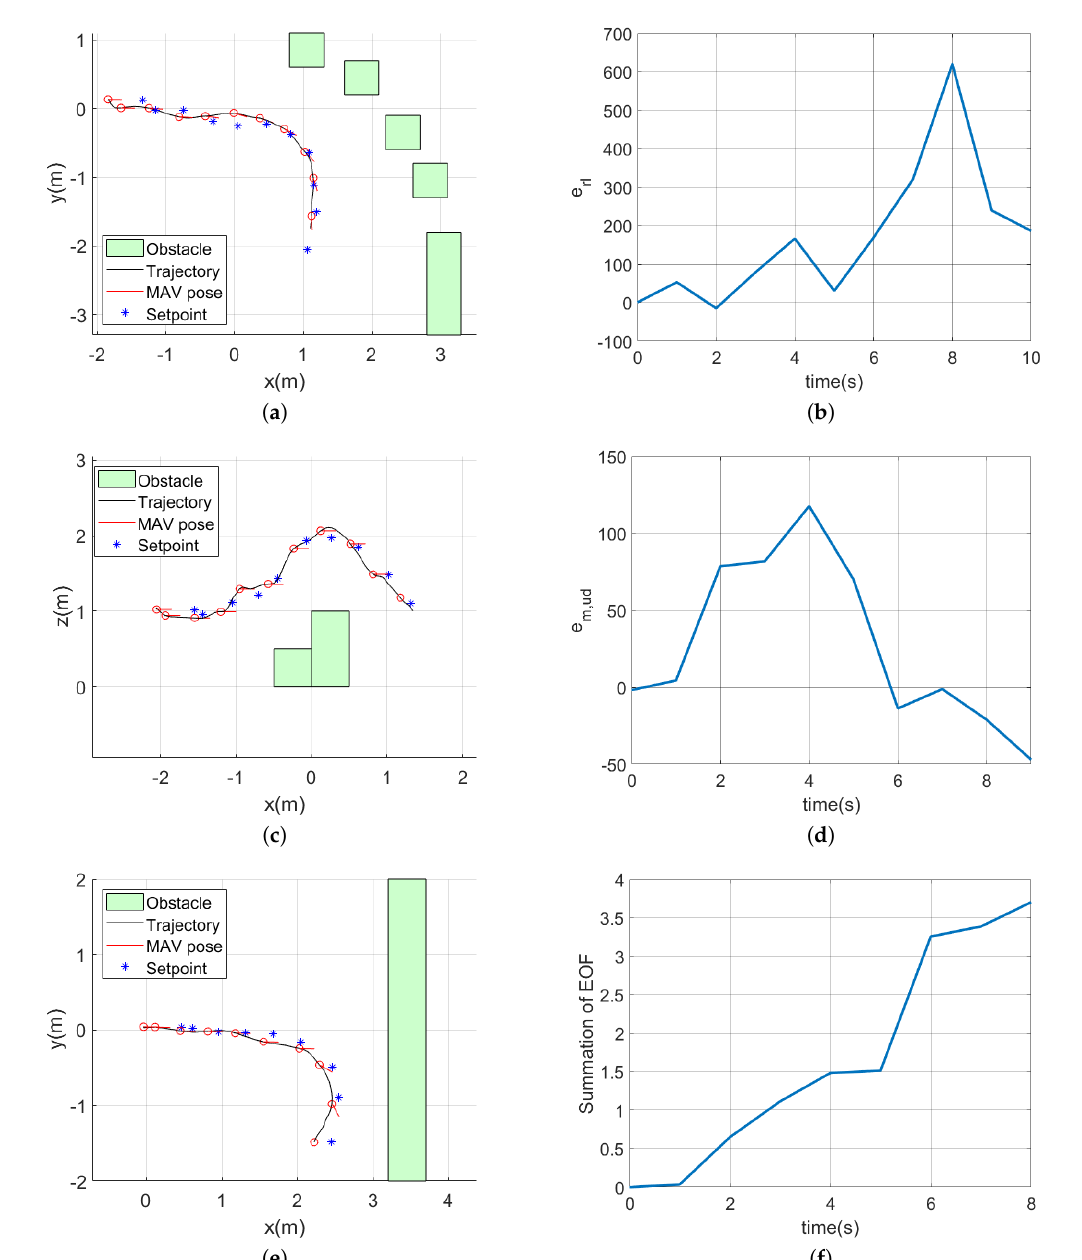
Figure 17. Trajectories of the MAVand time history of the optical flow difference or the sum of the EOF: ( a ) trajectory for the horizontal balance strategy experiment; ( b ) time history of the optical flow difference for the horizontal optical flow experiment; ( c ) trajectory for the vertical balance strategy experiment; ( d ) time history of the modified optical flow difference for the vertical balance strategy experiment; ( e ) trajectory for the frontal obstacle avoidance strategy experiment; and ( f ) time history of the summation of the EOF for the frontal obstacle avoidance strategy